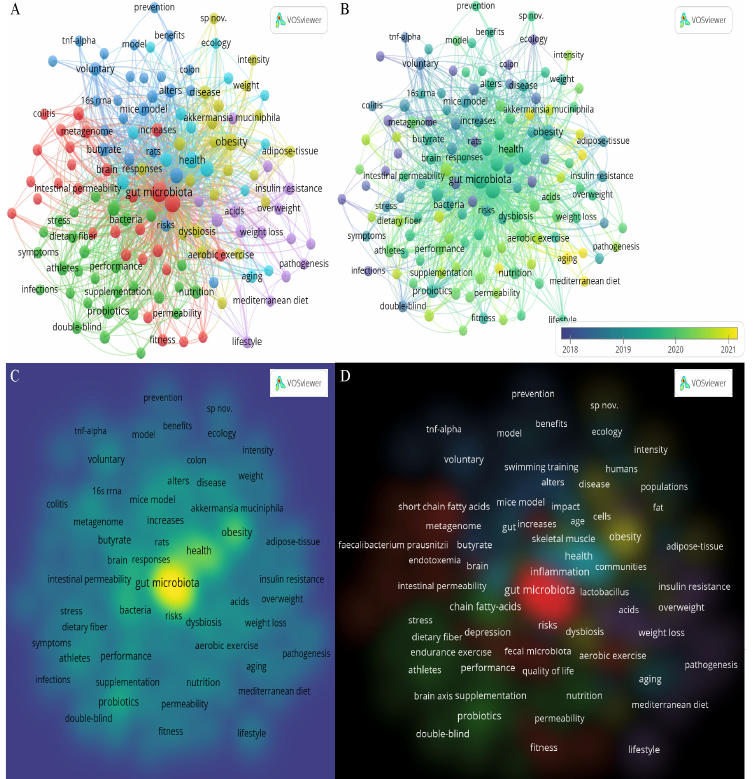
Figure 7. Network visualization map of terms in title/abstract fields of publications related to microbiome and exercise. ( A ) Network visualization. ( B ) Overlay visualization. ( C ) Item density visualization. ( D ) Cluster density visualization.